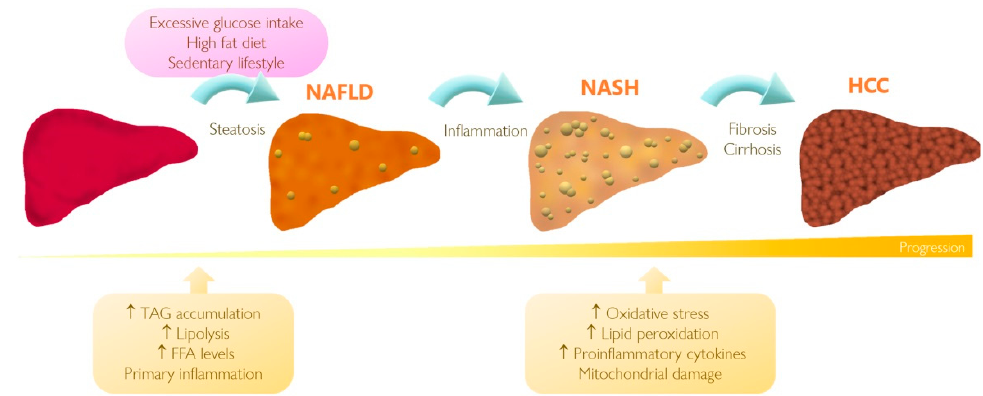
Figure 2. Progression of non-alcoholic fatty liver disease (NAFLD) to hepatocellular carcinoma (HCC). A passive lifestyle accompanied with high caloric diet intake can result in impairment of hepatic lipid metabolism and consequently progression of fatty liver disease. Although the stages of this pathology are not fully characterized yet, the impairment affects expression of genes regulating oxidative stress, lipid peroxidation, mitochondrial damage, and inflammation. When the corresponding noxae persists, simple hepatic steatosis can progress to the development of non-alcoholic steatohepatitis (NASH) and possibly HCC. FFA, free fatty acid; TAG, triacylglyceride. According to histopathological features, steatosis is characterized by increased storage of TAGs in hepatocytes [40]. A remarkable characteristic of this stage is the ballooning of hepatocytes, which is currently considered as a hallmark of NAFLD [40]. Steatosis is often associated with increased lipolysis and insulin resistance resulting in elevation of serum free fatty acid (FFA) levels, followed by TAG relocation from the liver to peripheral